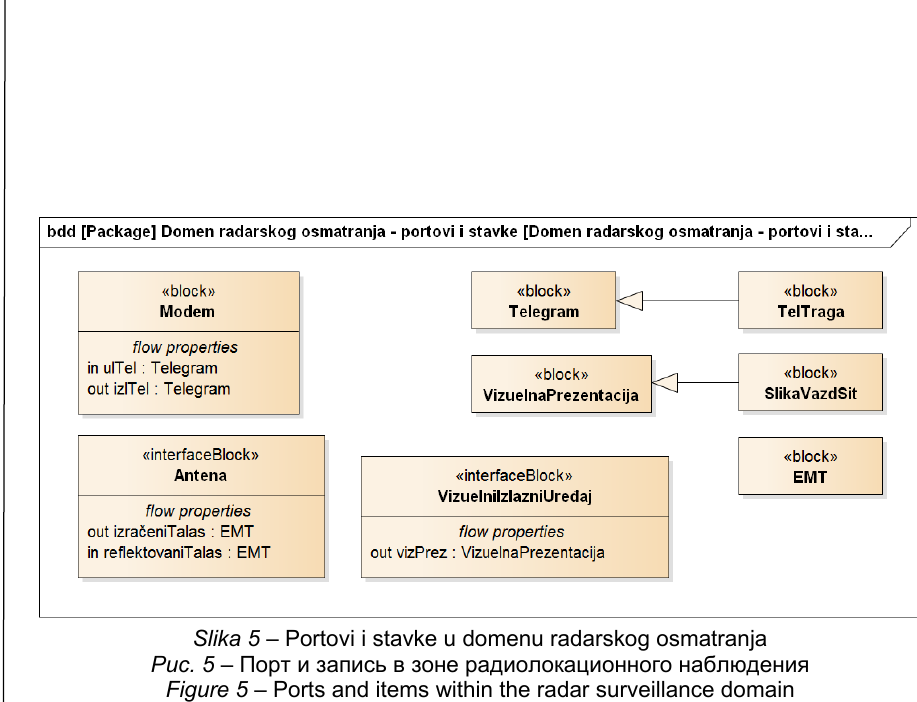
Рис . 5 – Порт и запись в зоне радиолокационного наблюдения Figure 5 – Ports and items within the radar surveillance